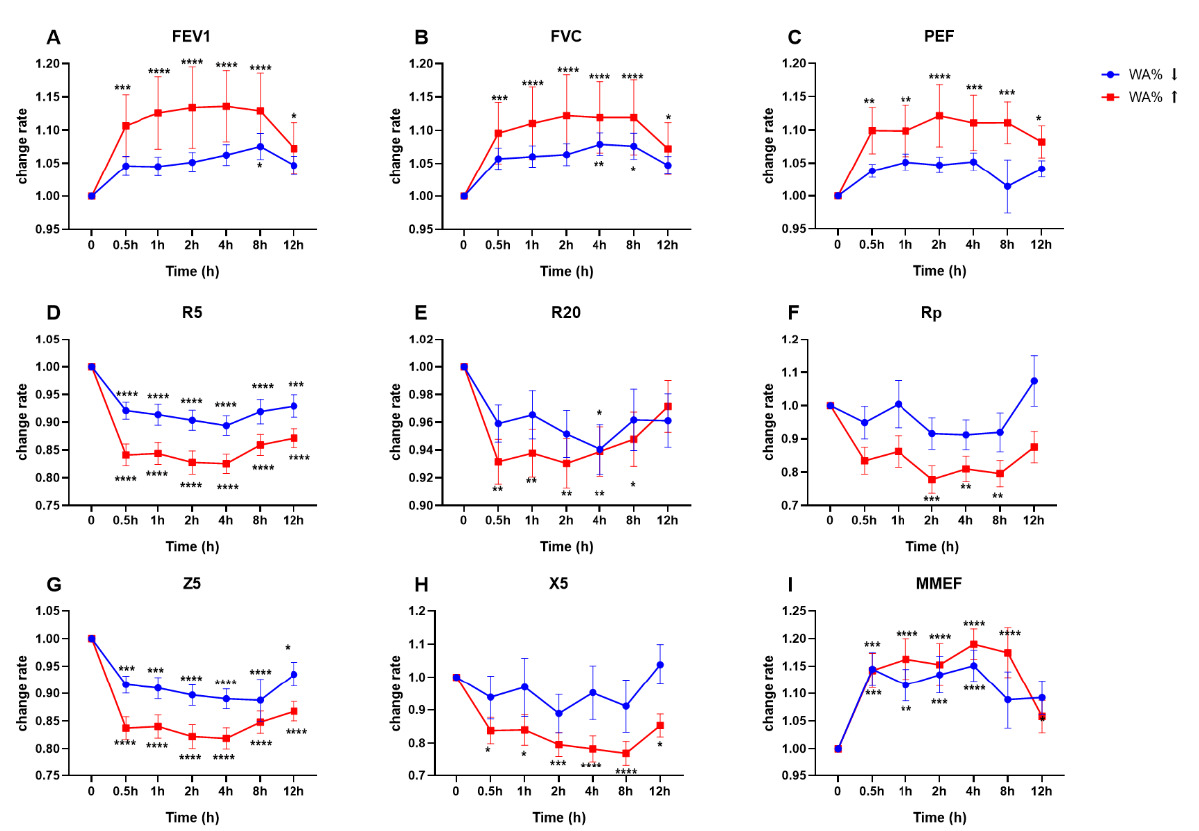
Figure 4. Temporal changes of lung function based on WA%. ( A ) FEV1, forced expiratory volume in one second; ( B ) FVC, forced vital capacity; ( C ) PEF, peak expiratory flow; ( D ) R5, airway resistance at 5 Hz; ( E ) R20, airway resistance at 20 Hz; ( F ) Rp, peripheral resistance; ( G ) Z5, impedance value at 5 Hz; ( H ) X5, reactance at 5Hz; ( I ) MMEF, maximal mid-expiratory flow. The blue symbol means subject with relative non-thickened airways, and the red colour represents cohort with relative thickened airways. The dichotomisation threshold was generated based on the median value of WA%. * p < 0.05, ** p < 0.01, *** p < 0.001, **** p < 0.0001. Comparisons were made between the specific timepoint and baseline lung function.